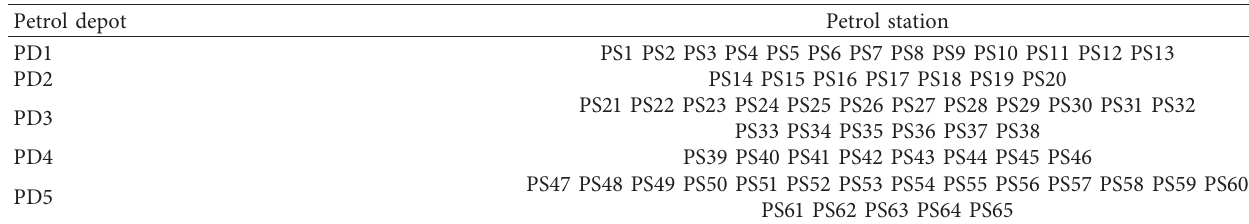
Table 7: Petrol stations’ assignment in the grand coalition.